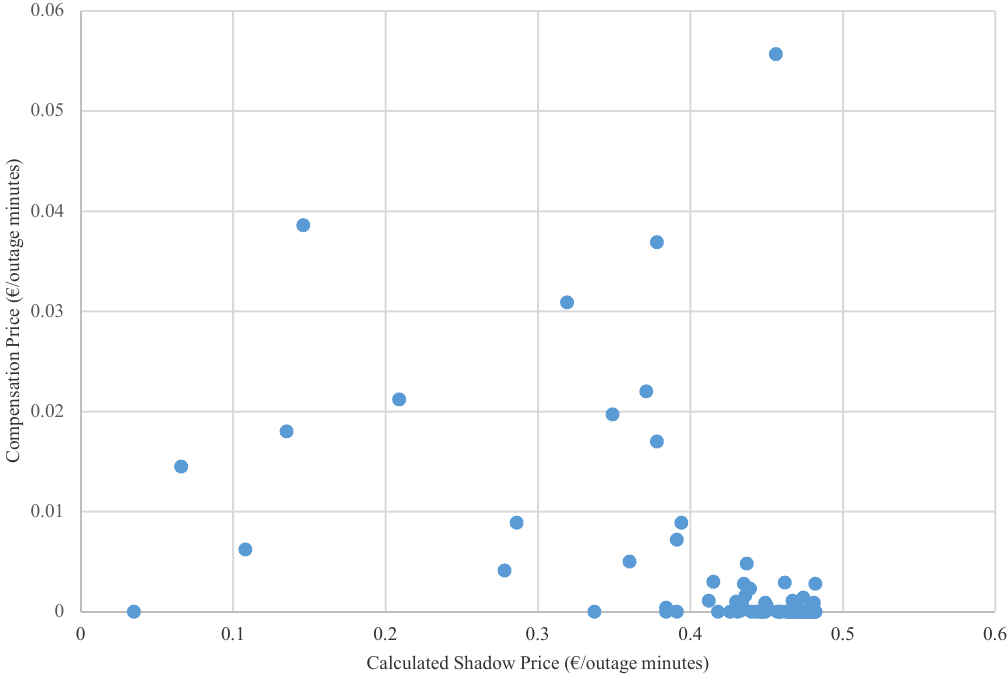
Figure 3. Comparison of compensation price vs. shadow price.